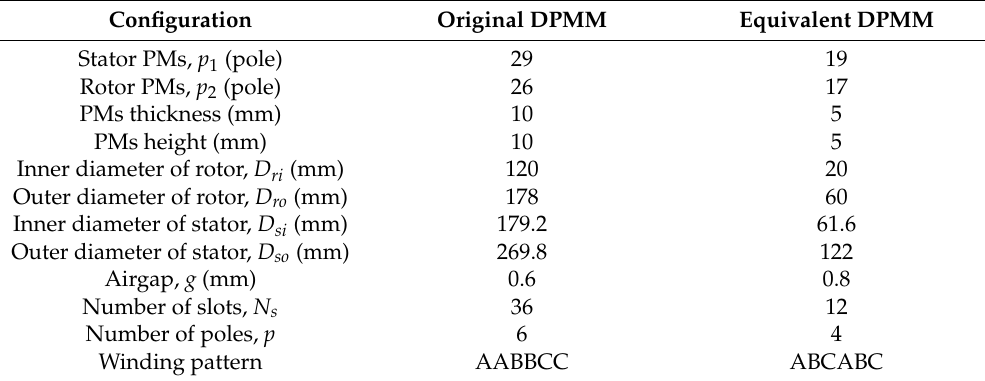
Table 1. Dimensions of the studied